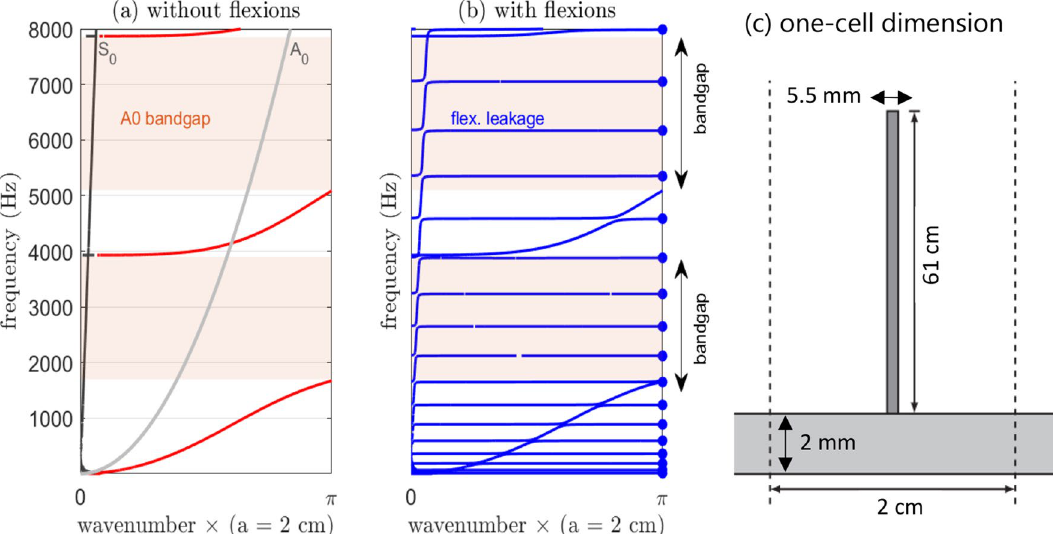
Figure 1. Theoretical dispersion relation for an infinite array of beams [Colquitt 2016]. ( a ) Dispersion curves obtained ignoring beam flexural resonance effects. ( b ) Dispersion curves with flexural resonance effects. ( c ) Cell dimensions and properties: Lattice constant a = 2 cm; beam length L = 0.61 m; beam diameter db = 5.5 mm; plate stiffness h = 2 mm; and aluminum for the material (E = 69 GPa, nu =